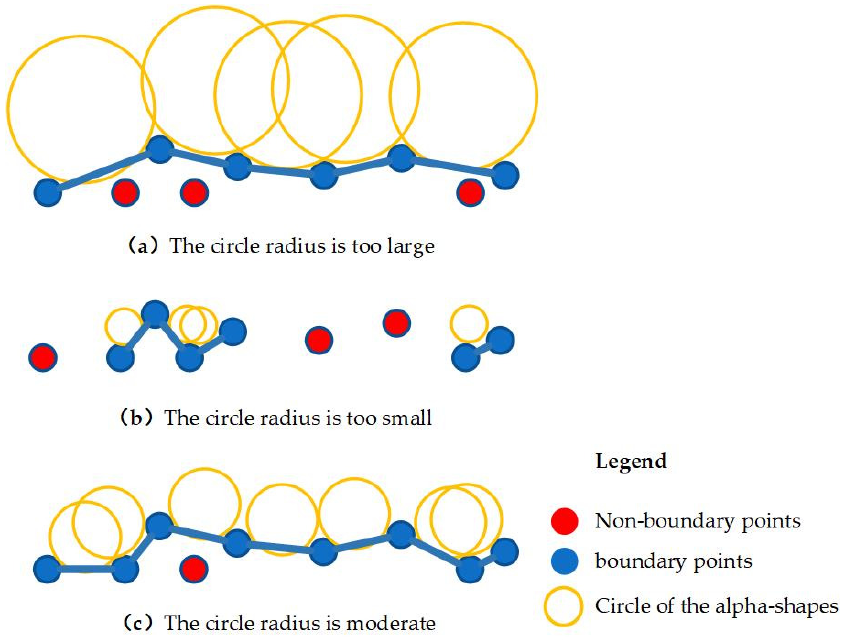
Figure 4. Alpha-shape boundary extraction. Table 2. Reference range of circle radius a .